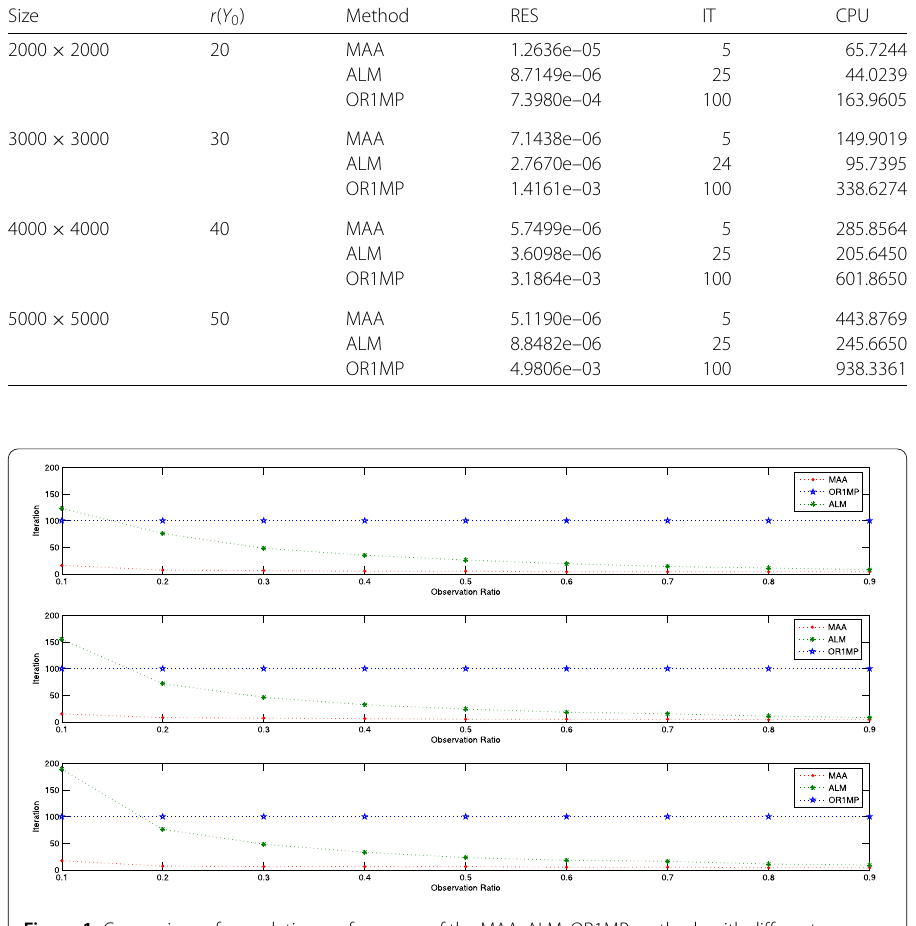
Figure 1 Comparison of completion performance of the MAA, ALM, OR1MP methods with different percentages of observations: the figures correspond to the results on three 3000 × 3000 random matrices